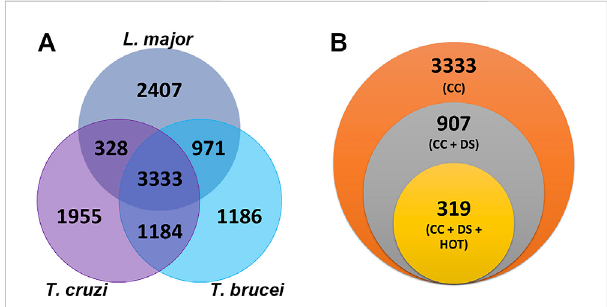
FIGURE 2 Selection of common drug target candidates in TriTryps (A) Clusters obtained by using MMseqs2. Venn diagram representing the intersection of similar genes for the three parasites (B) Potential drug targets common to Trypanosoma cruzi , Trypanosoma brucei and Leishmania major . Each circle depicts the number of proteins obtained after applying the indicated fi lter. Orange: 3,333 common clusters for the three parasites. Gray: 907 common clusters where the three proteins have a DS ≥ 0.5. Yellow: 319 common clusters where the three proteins also have a HOT ≥ 0.7.